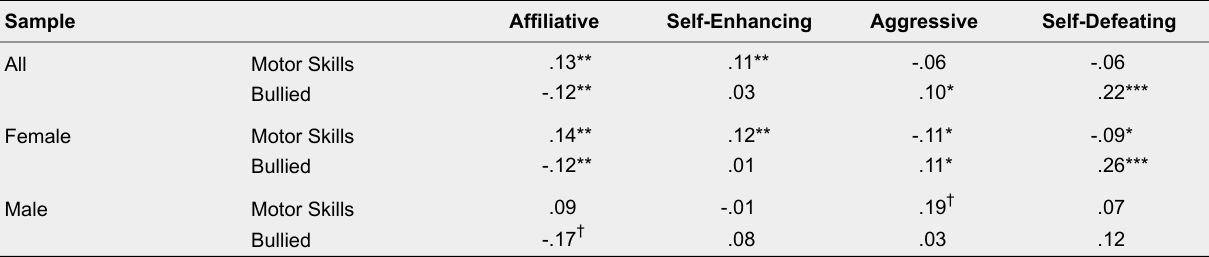
Correlations for Good Motor Skills and Being Bullied With HSQ